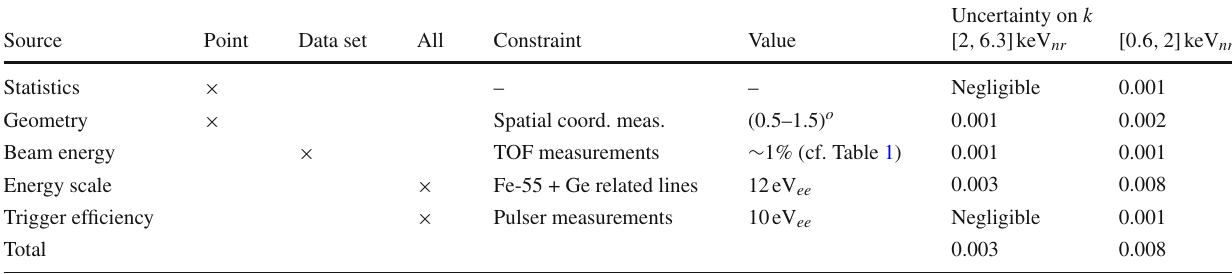
Table 4 Summary ofthe uncertaintiessources takenintoaccount inthe analysis.Statisticsandgeometryuncertaintiesareuncorrelatedbetween the points, whereas beam energy uncertainties are correlated for each data set. HPGe detector modeling effects are fully correlated. Their